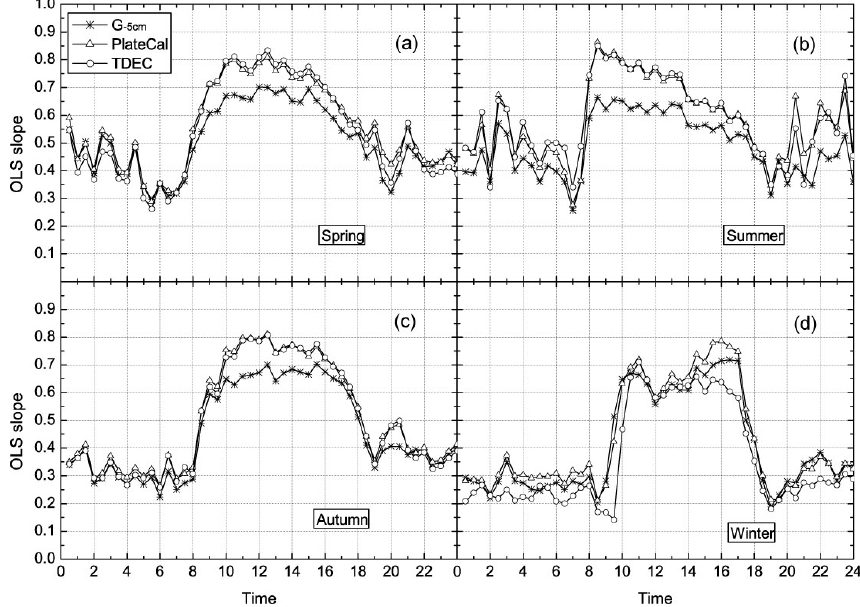
Fig. 7. Comparison between the diurnal variation of seasonal EBC computed by using the ground heat flux measured at a depth of 5cm, and the surface soil heat flux calculated using PlateCal and TDEC at SACOL site in the (a) spring, (b) summer, (c) autumn, and (d)